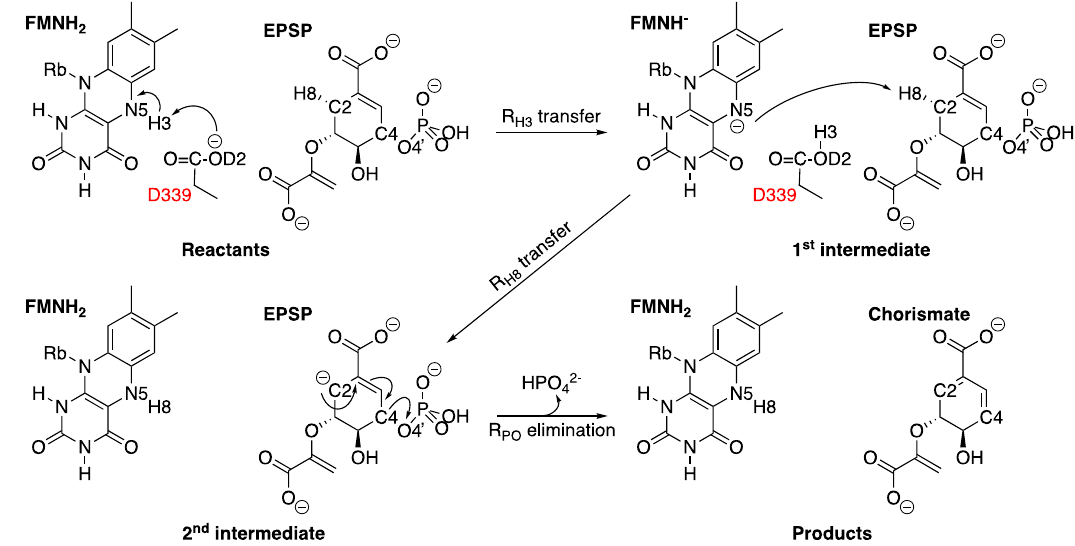
Figure 18. Proposed catalytic mechanism for the CS reaction based on quantum mechanics/molecular mechanics (QM/MM) with the interaction of aspartic acid 339 (D339).